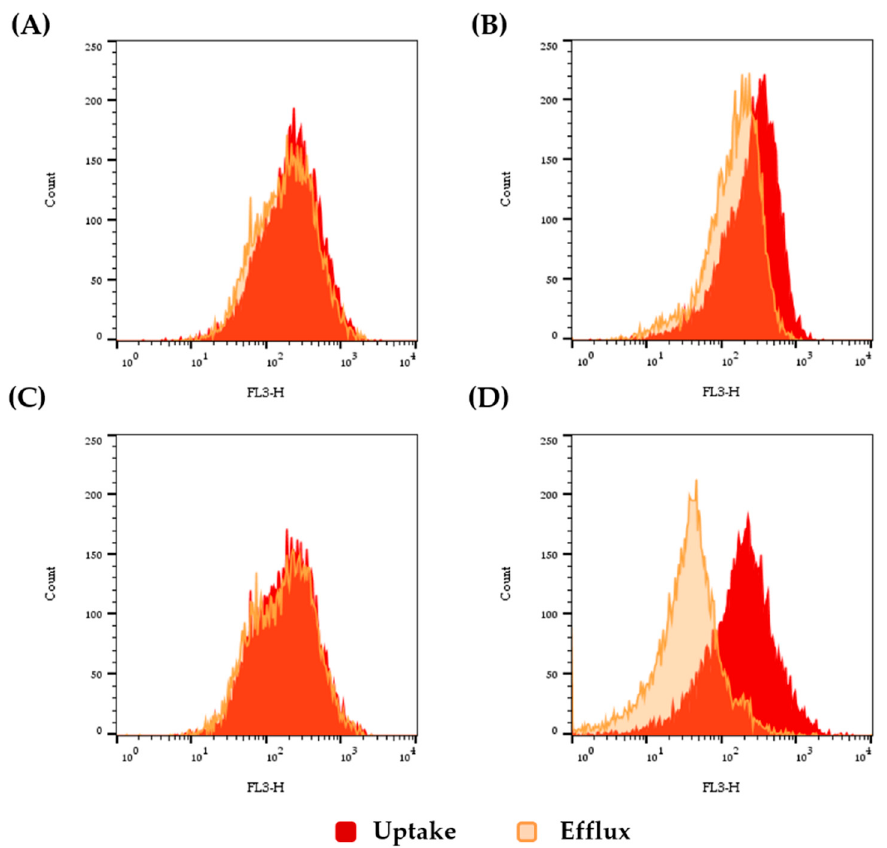
Figure 1. Flow cytometry analysis of the glucose-induced rhodamine 6G (R6G) efflux. Uptake of fluorochrome was quantified by incubating yeast cells in PBS for 60 min with 10 µM of R6G (red curve). Next, efflux was evaluated by quantifying the residual fluorescence of the cells after the removal of the free dye and with an additional incubation in phosphate-buffered saline (PBS) supplemented with 100 mM of glucose (orange curve). Fungal species: ( A ) C. tropicalis (ATCC 750), ( B ) C. krusei (ATCC 6258), ( C ) C. lusitaniae (ATCC 200950), and ( D ) C. haemulonii (LIPCh4). Each experiment was performed at least for three independent times with similar results.